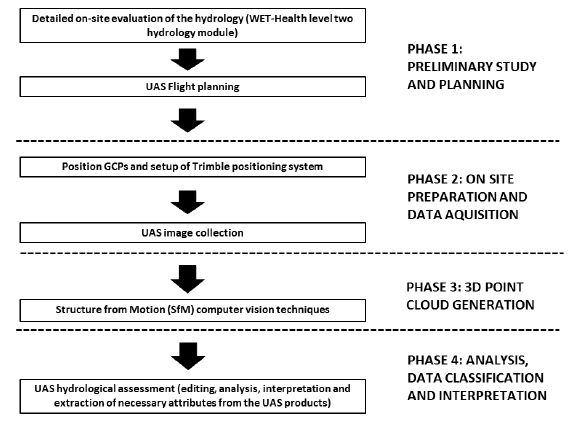
Figure 2. Flow diagram of methodology.